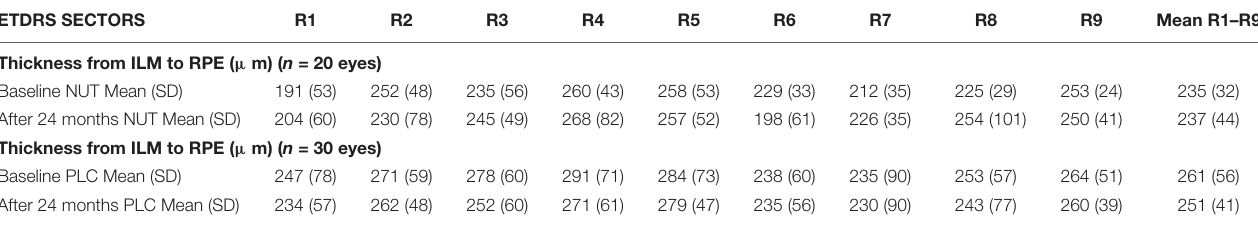
TABLE 7 | Bayesian analysis of visual function in RP patients after 2 years of the nutritional supplementation. Bayesian analysis at baseline ES 95% CrI Pr of PLC < NUT ROPE Pr of PLC > NUT P